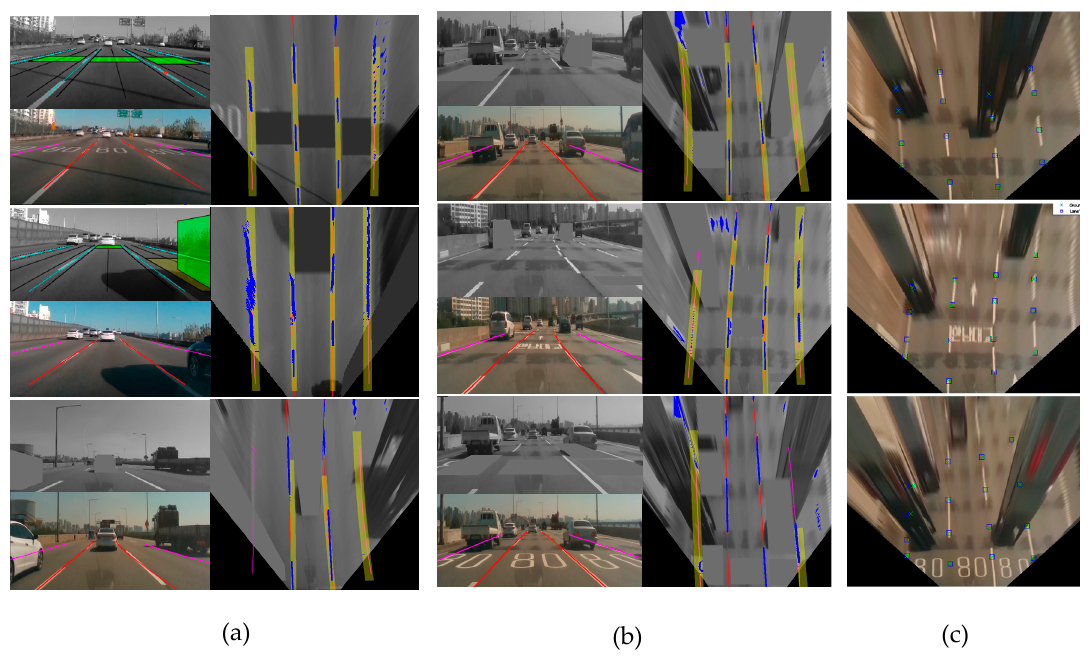
Figure 12. Experimental results and validation ( a ) scenario I: successful masking of the road marker, side vehicle emergence, front, and side vehicles. ( b ) Scenario II: successful masking of a complex scenario, ( c ) ground truth and results from the top view for validation.